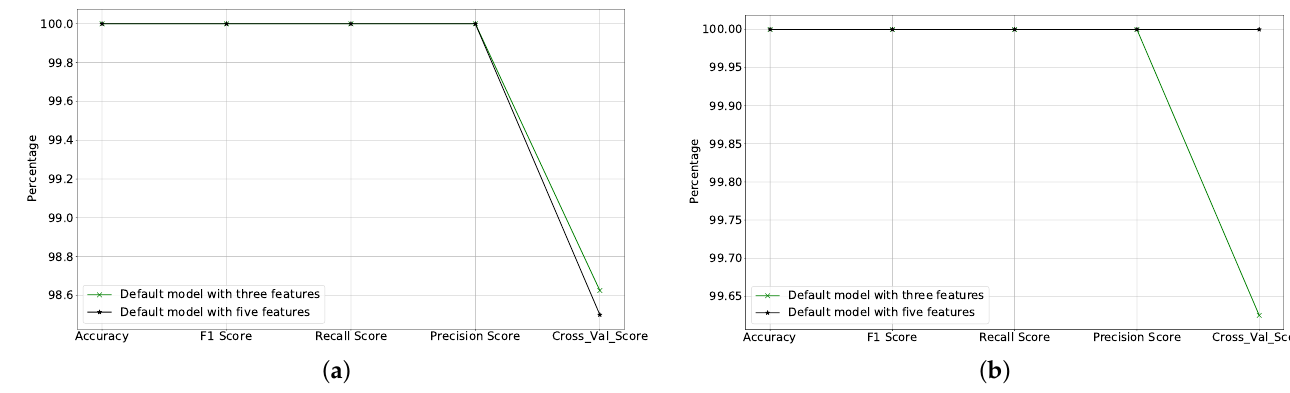
Figure 13. Performance evaluation of RF and DT algorithms: ( a ) DT algorithm; ( b ) RF algorithm. Table 4. Performance metrics of selected